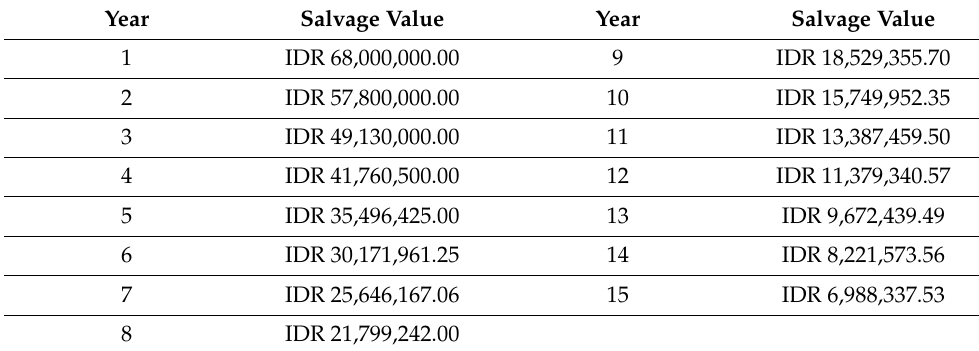
Table 8. Machine depreciation for 15 years with a depreciation rate of